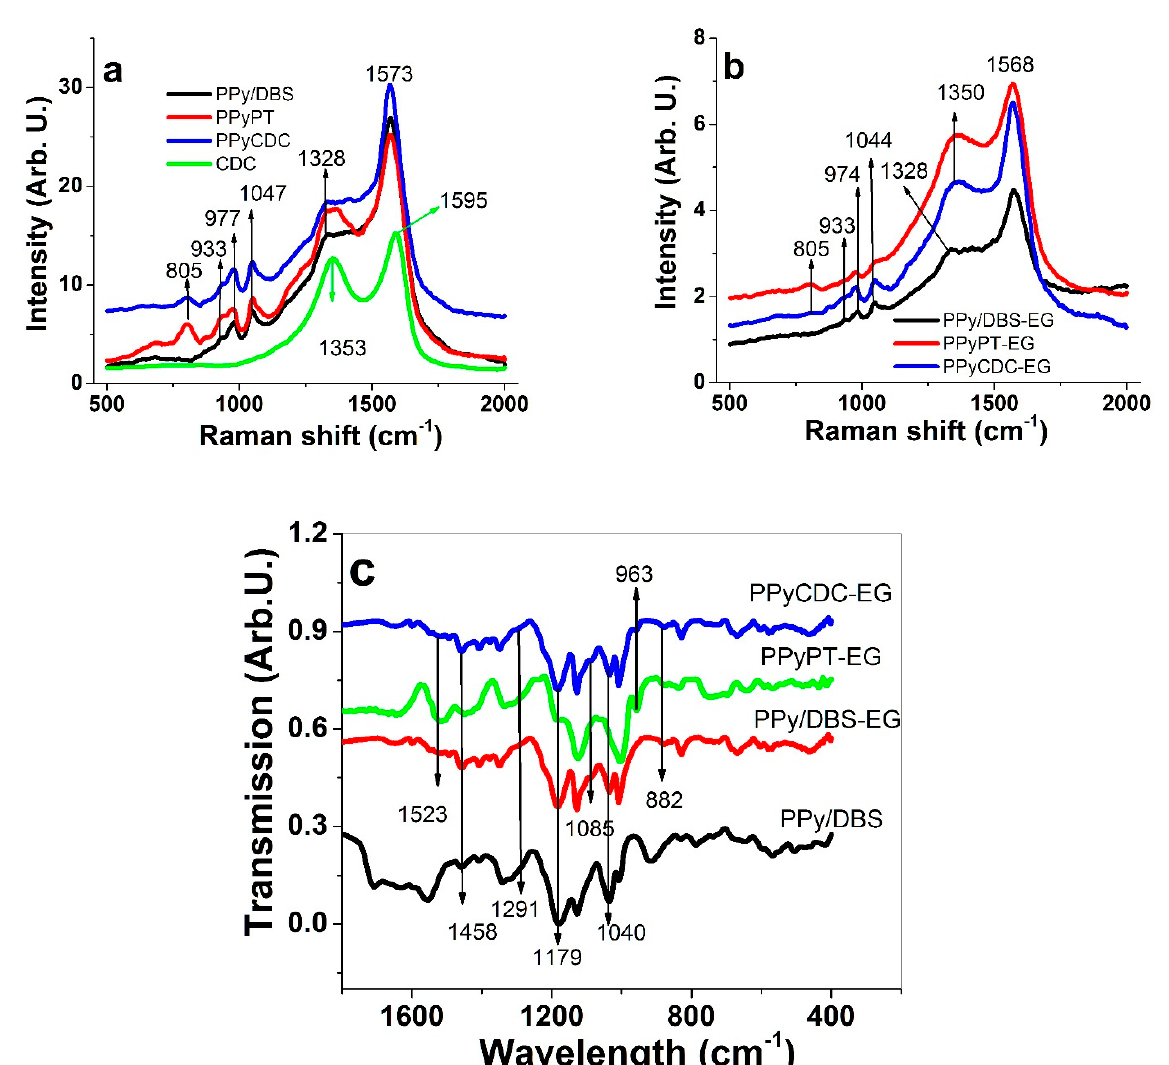
Figure 2. Raman spectroscopy (500–2000 cm − 1 , 514 nm) of PPy composites (PPy/DBS, black line; PPyPT, red line; PPyCDC, blue line) presenting in ( a ), PPy composites made in EG:Milli-Q+ mixture with addition of CDC (green line) and in ( b ), those made in pure EG solvent. Presented in ( c ), FTIR spectroscopy (400–1800 cm − 1 with PPy/DBS (black line), PPy/DBS-EG (red line), PPyPT-EG (green line) and PPyCDC-EG (blue line).